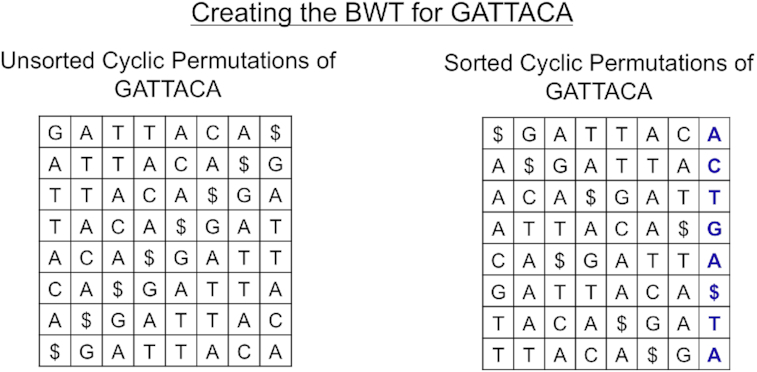
Diagram of how the Burrows-Wheeler transform is created. (Left) All cyclic permutations of the text “GATTACA.” (Right) The Burrows-Wheeler matrix of the text consisting of the sorted cyclic permutations of the text.